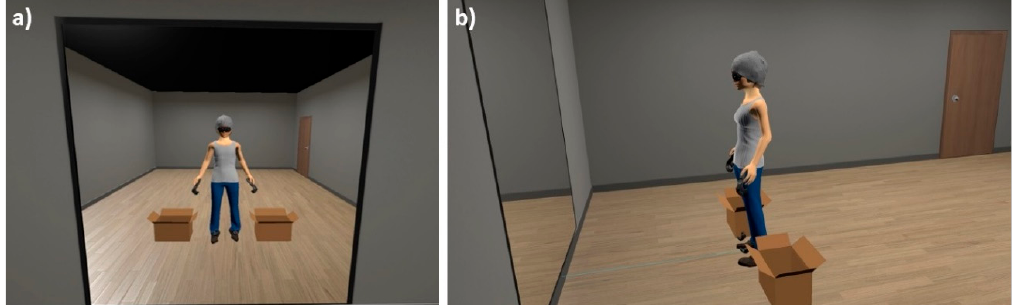
Figure 1. VR immersive environment and female avatar. From left to right: ( a ) participant’s front view; ( b ) profile view.